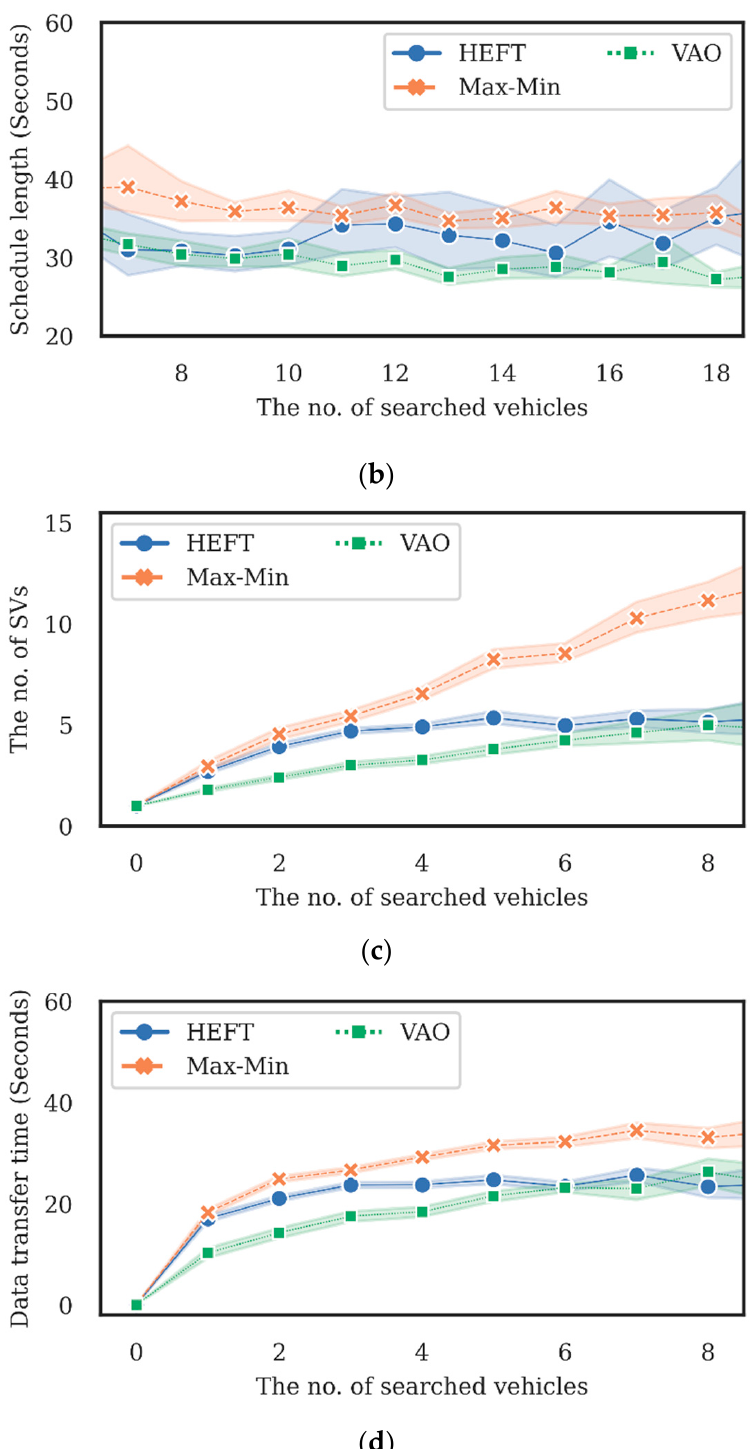
Figure 6. Schedule length and data transfer time for a depth 4 and width 4 DAG application: ( a ) Schedule length against the number of searched vehicles; ( b ) Schedule length against the number of searched vehicles; ( c ) The number of SVs against the number of searched vehicles; ( d ) Data transfer time against the number of searched vehicles.